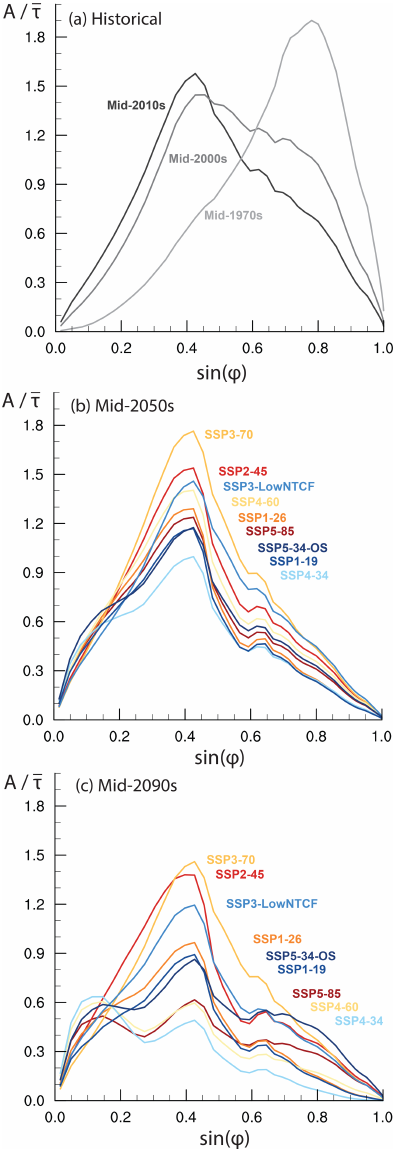
Figure 4. Hemispheric asymmetry of τ in the MACv2-SP interpre- tation of CMIP6 scenarios. Shown is the hemispheric asymmetry, A , weighted by the global mean τ . All values are computed for τ at 550nm for (a) selected years from the historical reconstruction, as well as each CMIP6 emission scenario for both (b) the mid-2050s and (c) the